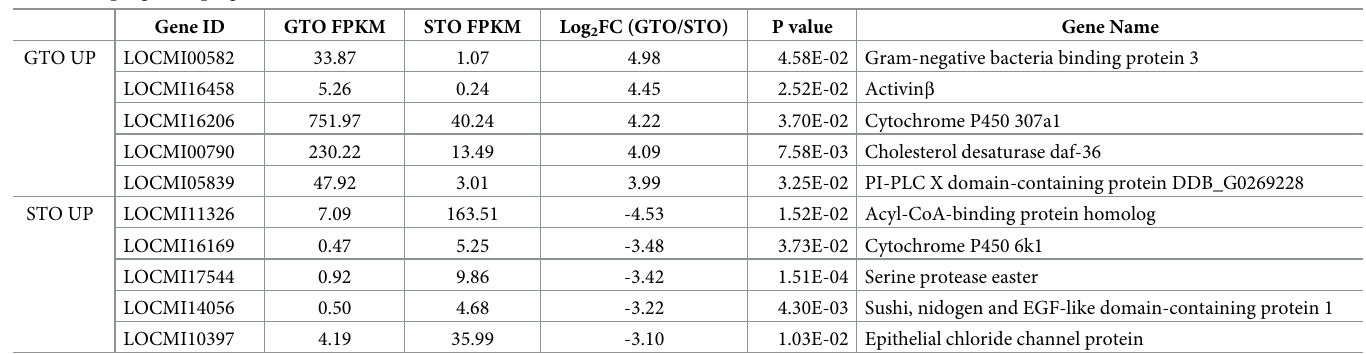
Table 1. Top 5 genes upregulated in GTO or